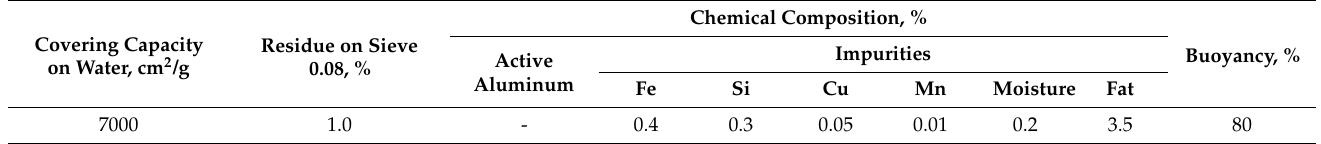
Table 3. Physical properties and chemical composition of aluminum powder.